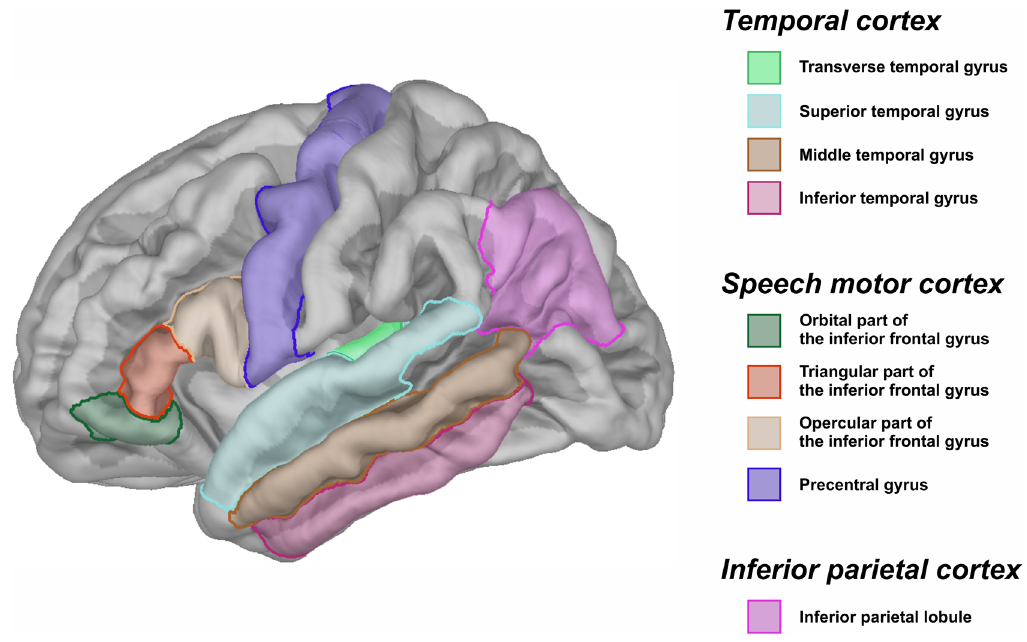
Figure 1. Language-related regions of interest (ROIs) in the left